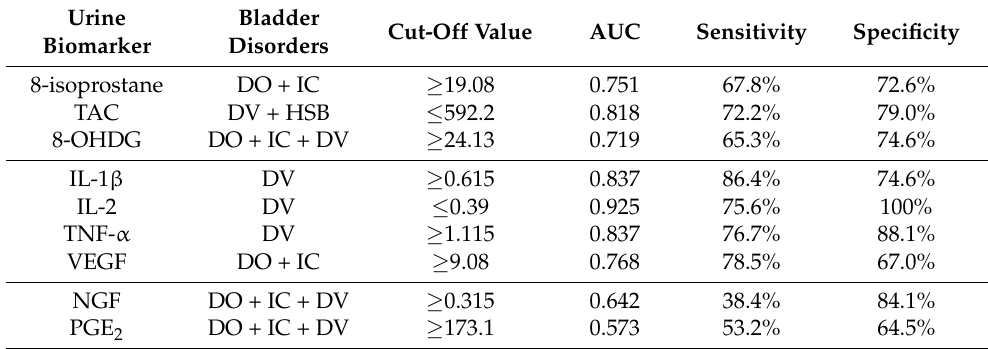
Table 5. Cutoff value to discriminate bladder dysfunctions and the sensitivity and specificity to identify bladder